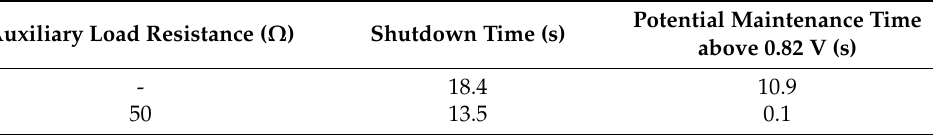
Figure 9. Comparison of discharge characteristics between the unoptimized and the optimized shutdown strategy. Table 4. Discharge characteristics parameters between the unoptimized and the optimized shutdown strategy.